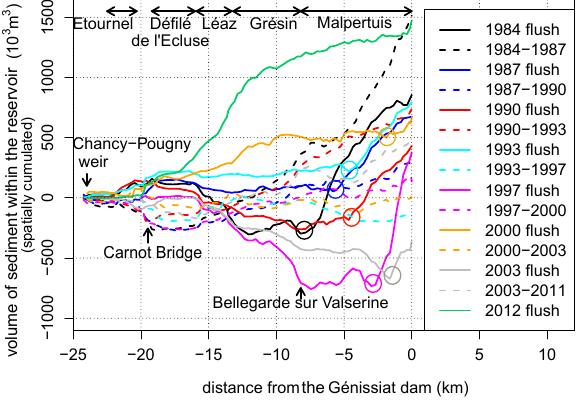
Fig. 4. Spatially cumulated sediment volume budget of the Génis- siat reservoir since 1984 (circles represent sharp changes in sedi- ment dynamics during